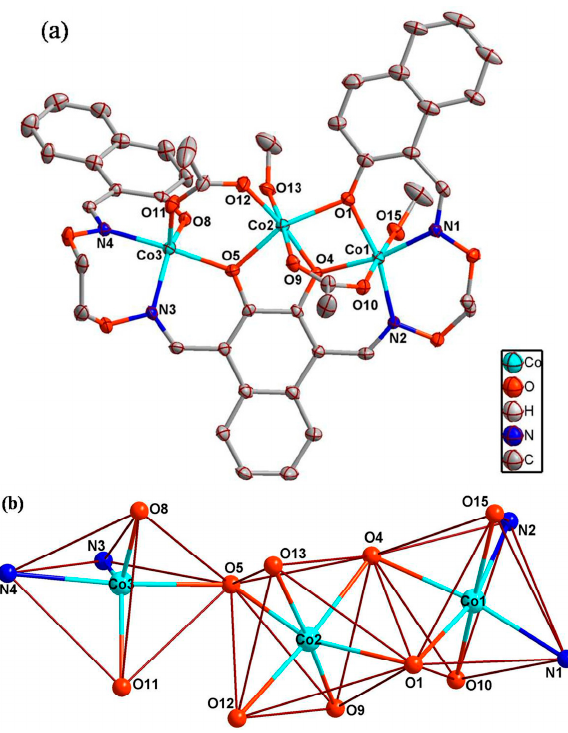
Figure 3. ( a ) Molecular structure and atom numbering of the Co(II) complex with 30% probability displacement ellipsoids (hydrogen atoms are omitted for clarity); ( b ) Coordination polyhedra for Co(II) ions.